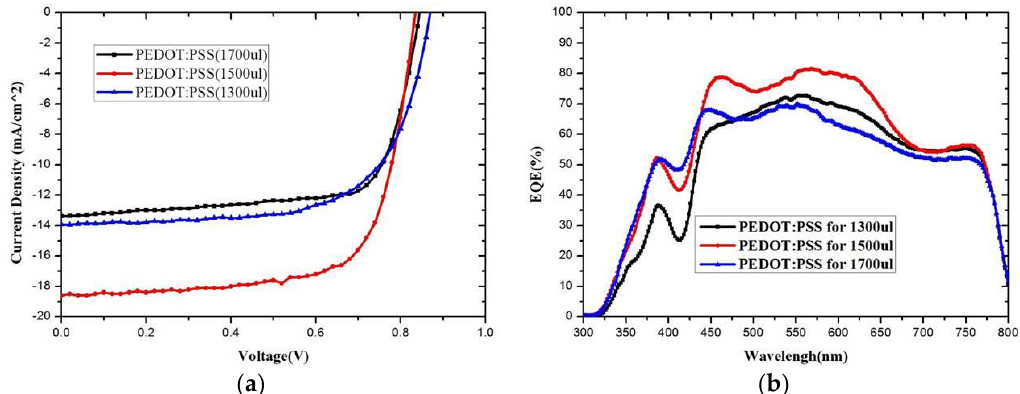
Figure 2. The ( a ) J–V curve and ( b ) external quantum efficiency (EQE) results for inverted PSCs, fabricated with 100 nm cathode and controlled under three extractions of 1700, 1500, and 1300 μL strictly. Table 1. The photovoltaic performance of the inverted PSCs 1 fabricated using three extractions of PEDOT:PSS solution of 1700, 1500, and 1300 μL, and the 100 nm Ag.